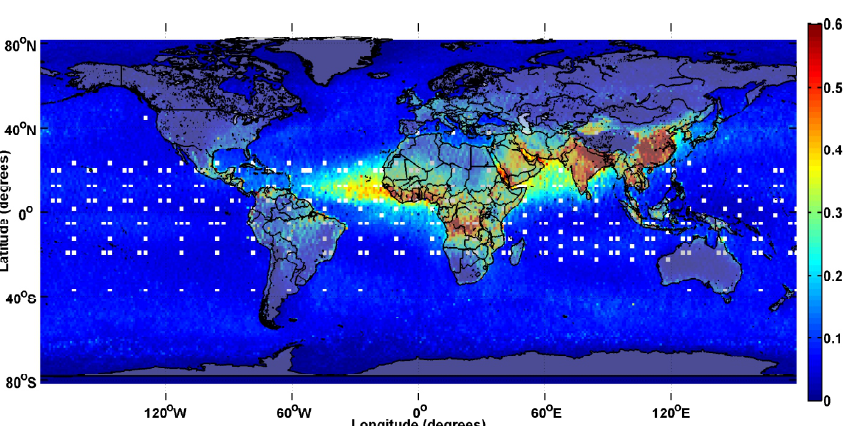
Figure 18. Global distribution of LIVAS AOD at